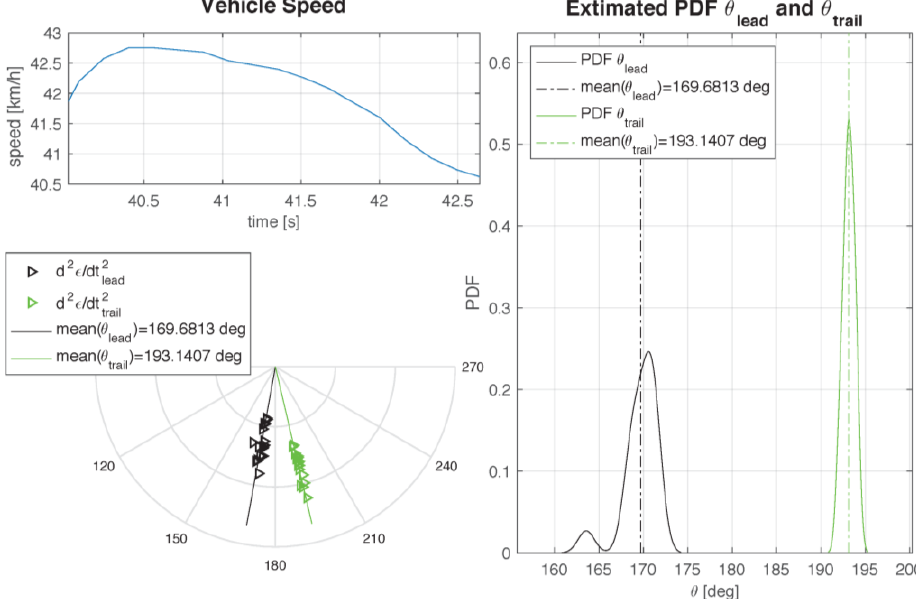
Figure 26. PDF and polar plot of footprint extrema and plot of local speed over time.